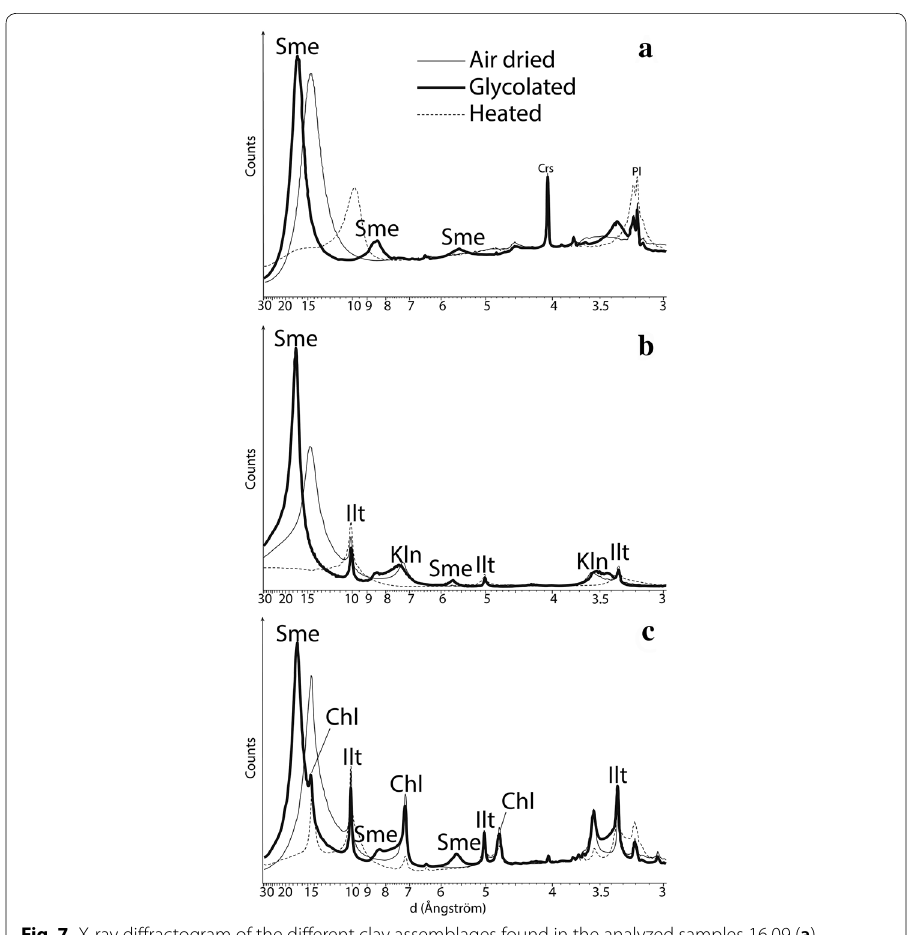
Fig. 7 X-ray diffractogram of the different clay assemblages found in the analyzed samples 16.09 ( a ), 15.142 ( b ), 16.01 ( c ). For their location, see Table 1. ( d (001), d (002) and d (003) are indexed, except for Kaolinite ( Kaol) where only d (001) and d (002) are indexed). Smectite ( Sme), Illite( Ill), Chlorite = = = ( Chl). A (from sample 16.09, Morne Morel): Smectite only; B (from sample 15.142, central part of = Terre-de-Haut, airfield): Smectite Illite Kaolinite Halloysite; C (from sample 16.01, north of Grande Anse): + + ± Smectite Illite Chlorite Kaolinite + + ± ±